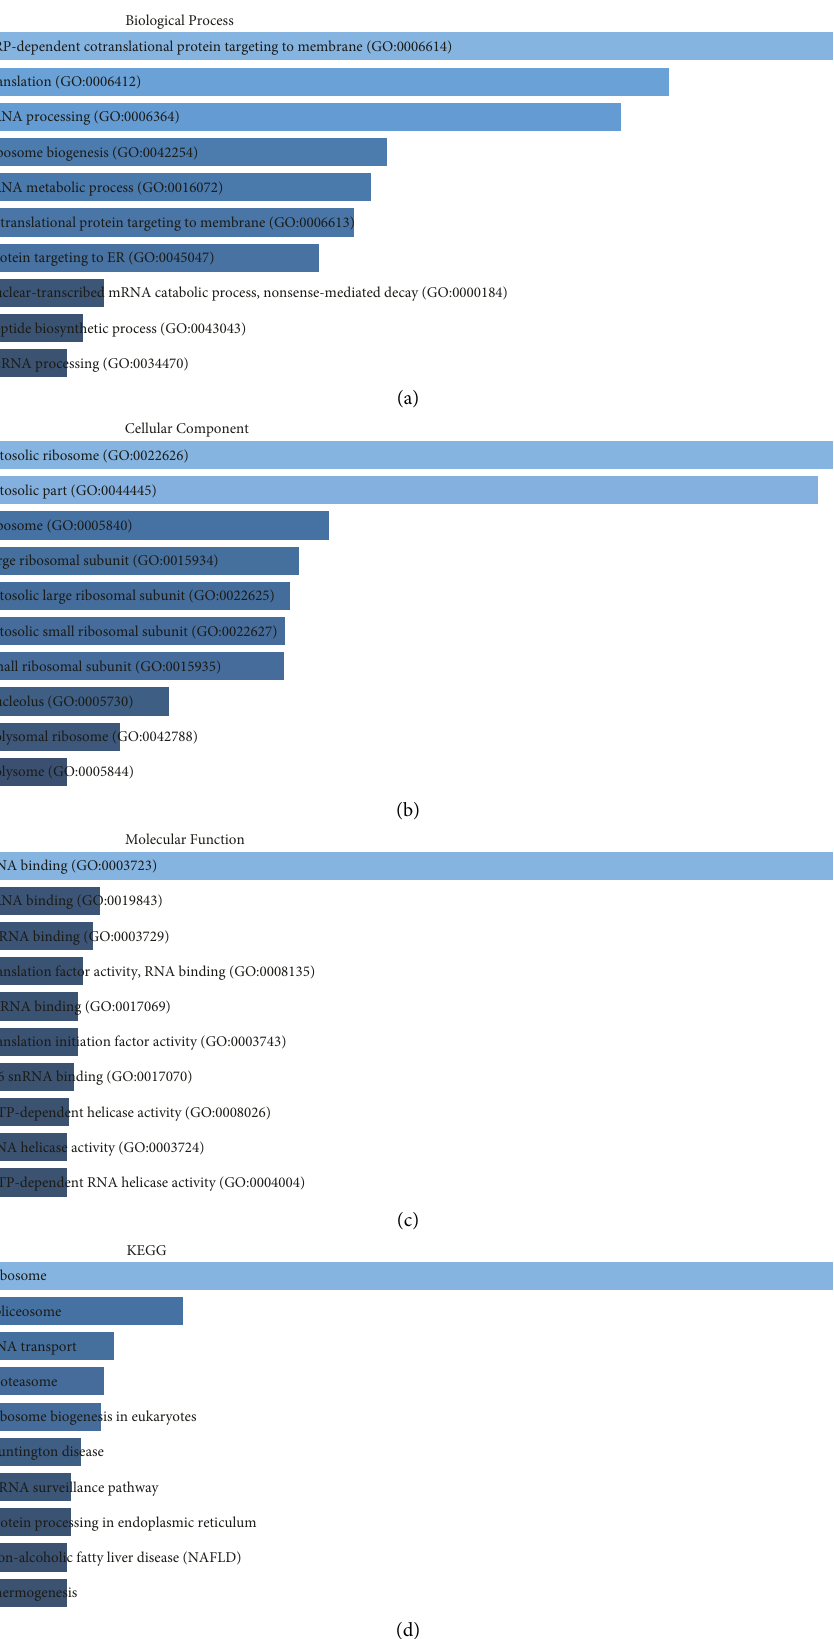
Figure 4: GO and KEGG analysis. (a–c) GO analysis of HM13-associated genes in BP, CC, and MF. (d) KEGG analysis of HM13-associated